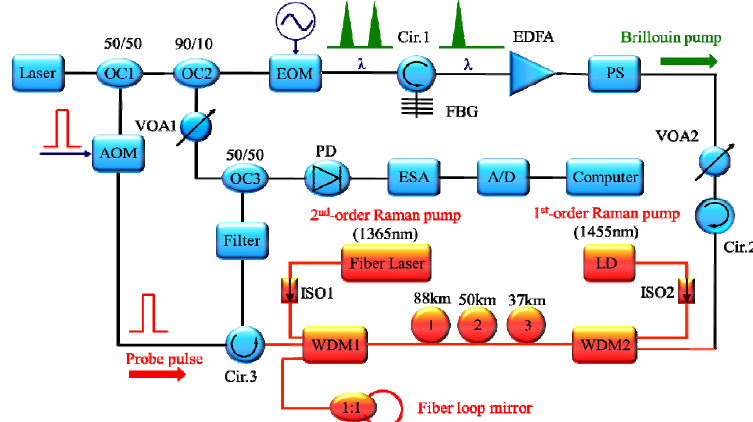
Fig. 9 Experimental setup of Ф -OTDR based on the HDA